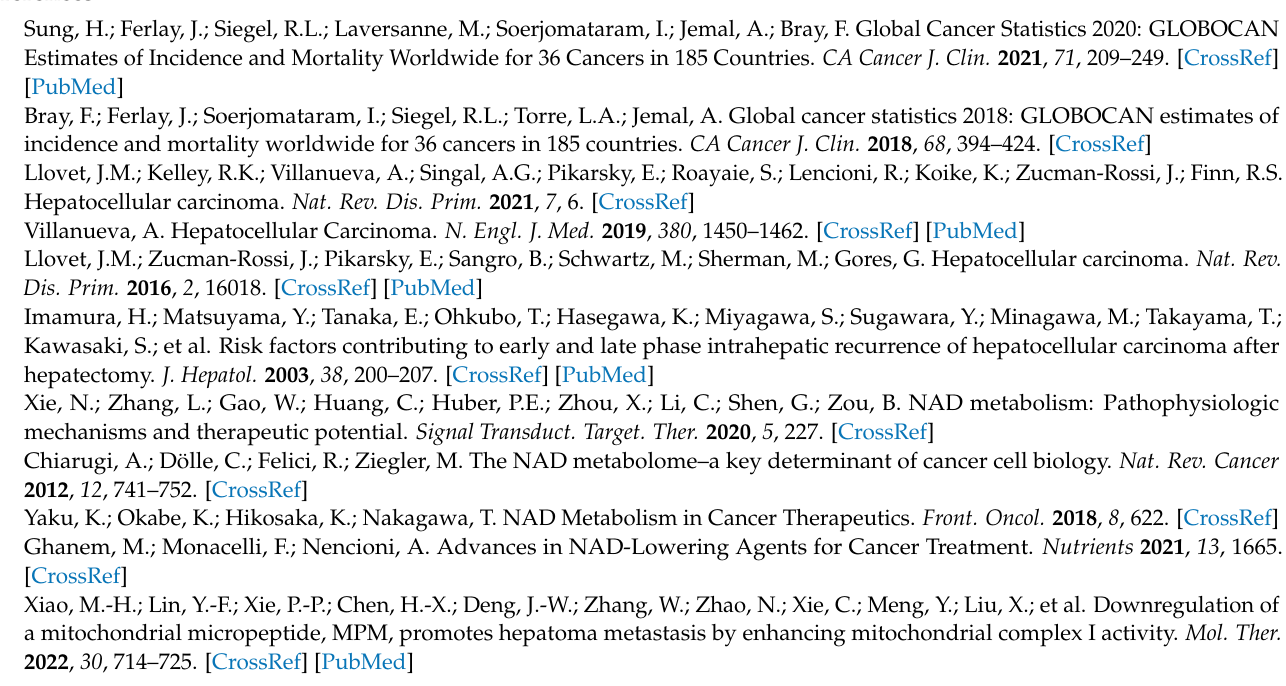
Table S1: The demographic and pathological characteristics of patients recruited in this